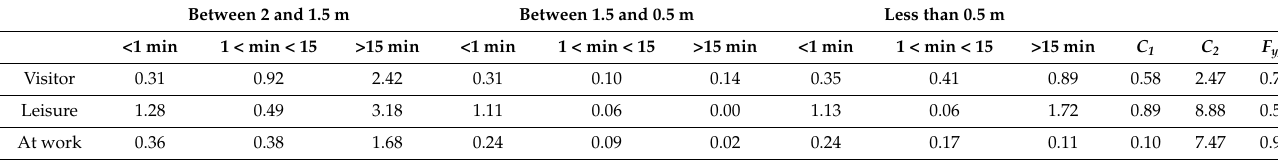
Table 2. Contact data used for the least-squares regression of A 1 and A 2 based on RIVM and survey data on the number of contacts per hour within a certain contact category, per